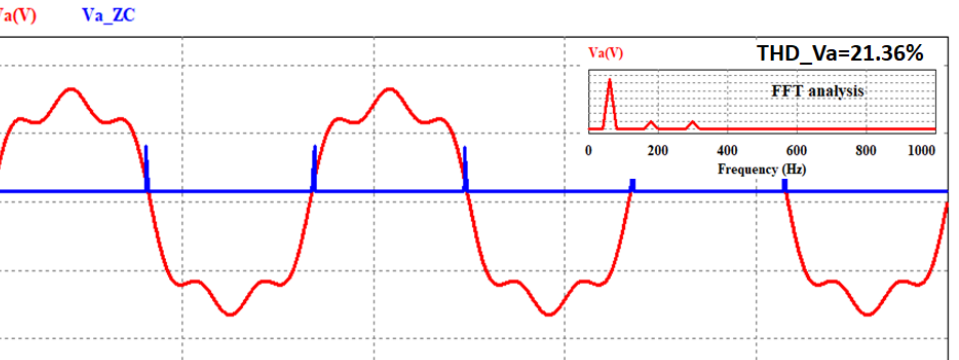
Figure 8. Zero-voltage crossing detection signal generation (Va_ZC) of a non-pure sine voltage waveform (Va).